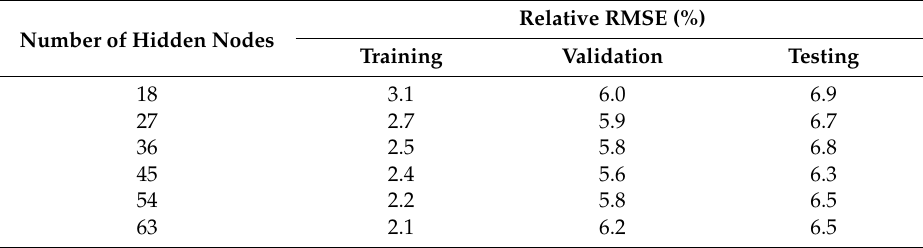
Table 2. Relative RMSE as a function of the number of nodes in the hidden layer. Number of Hidden Nodes